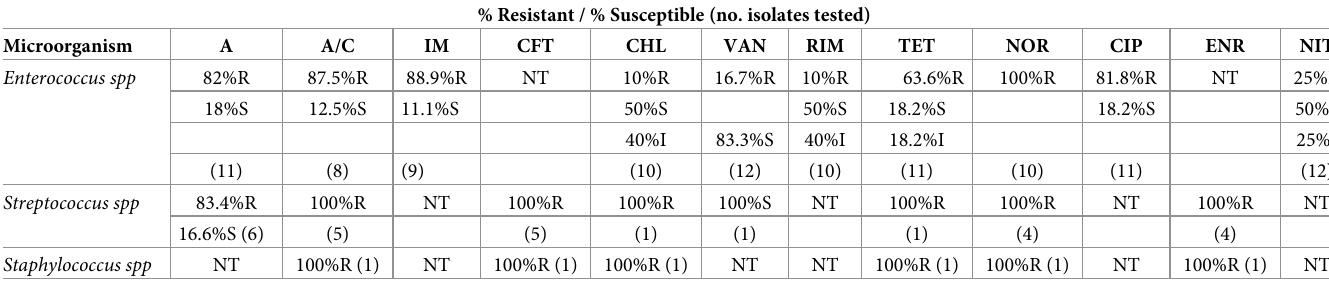
Table 3. Antibiogram results for the Gram-positive cultured